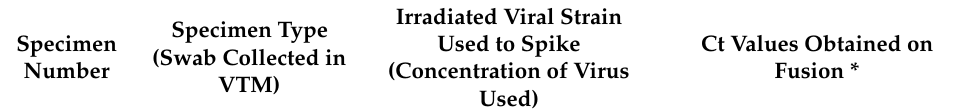
Table 3. Details and results obtained from contrived and clinical MPXV